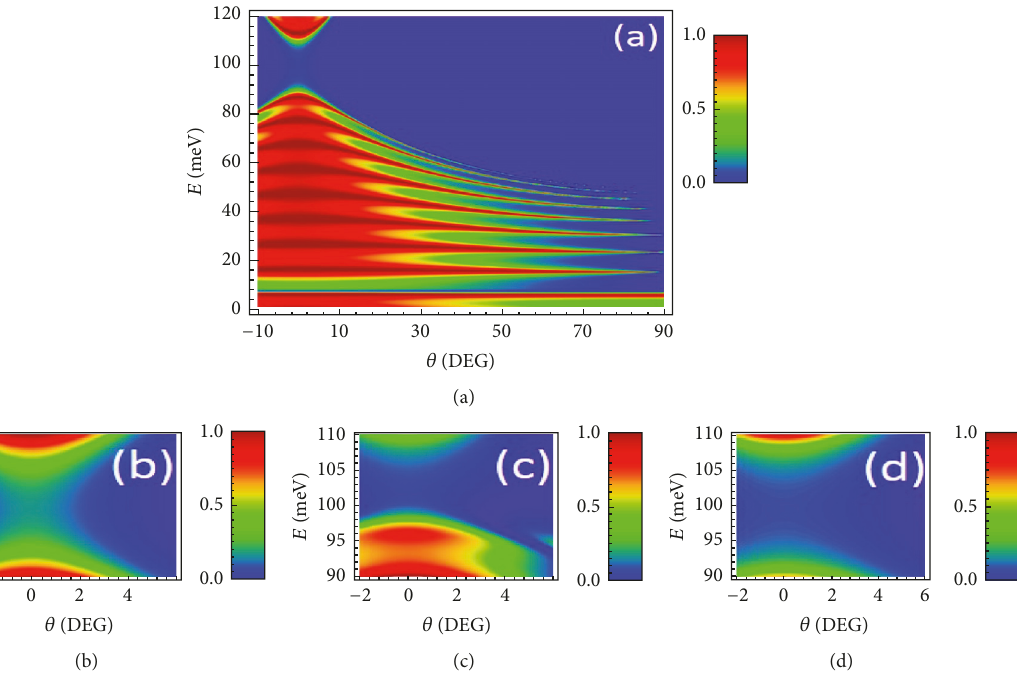
Figure 3: As in Figure 2 for spin-down electrons.